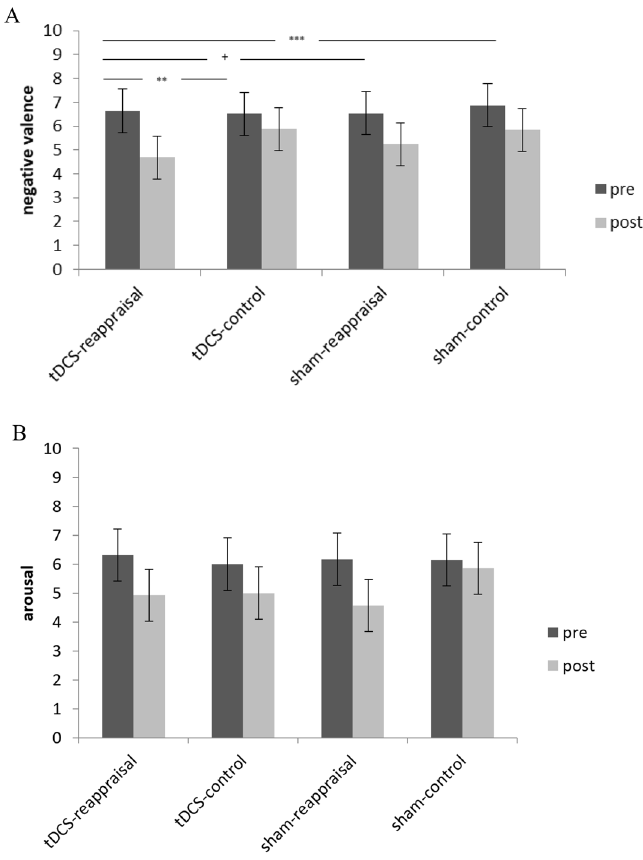
Figure 2. Results from repeated-measure ANCOVA for memory-related arousal and valence ratings during the experimental session. Depicted are differences in negative valence ( A ) and arousal ( B ) pre- and post- reappraisal for the four groups (tDCS-reappraisal, tDCS-control, sham-reappraisal, sham-control). Differences between groups in arousal were nonsignificant. Error bars represent standard errors (95% CI), † p < 0.1, *p < 0.05, **p < 0.01, ***p <